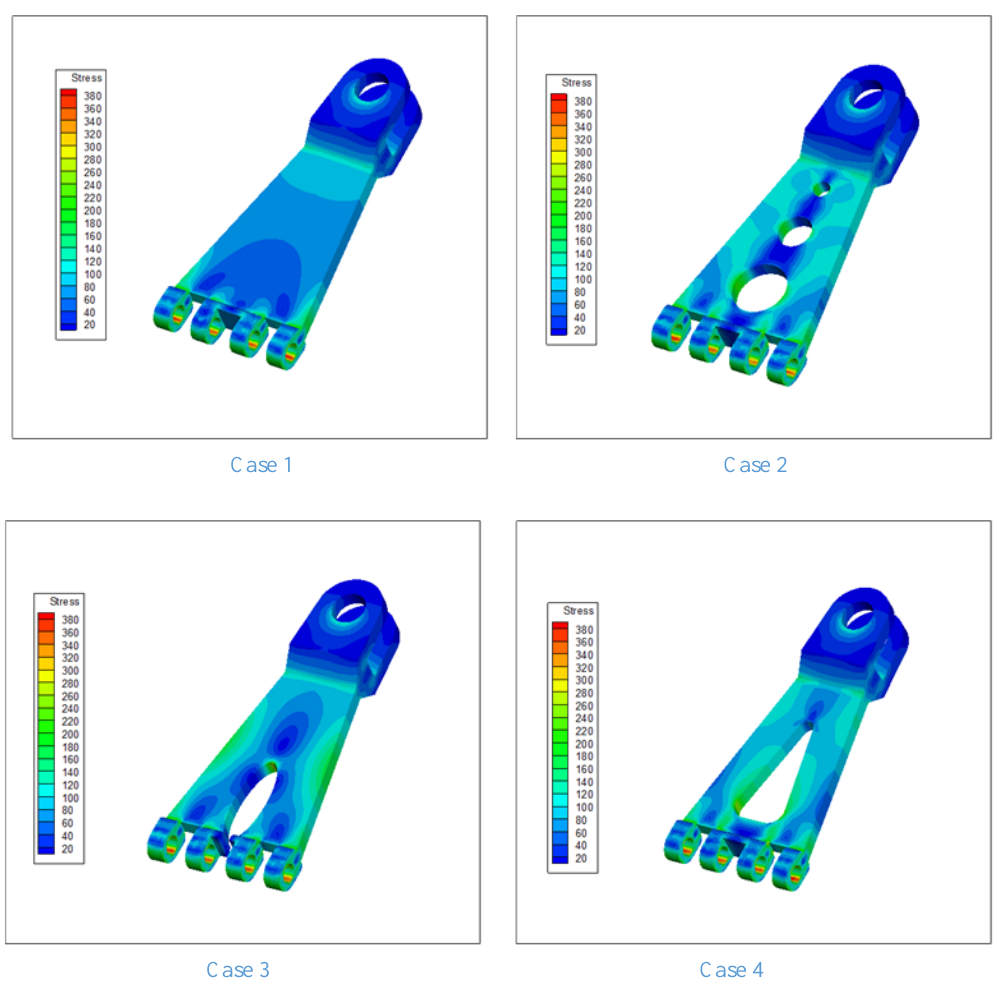
Figure 9. Initial von-Mises stresses distribution of the four cases.